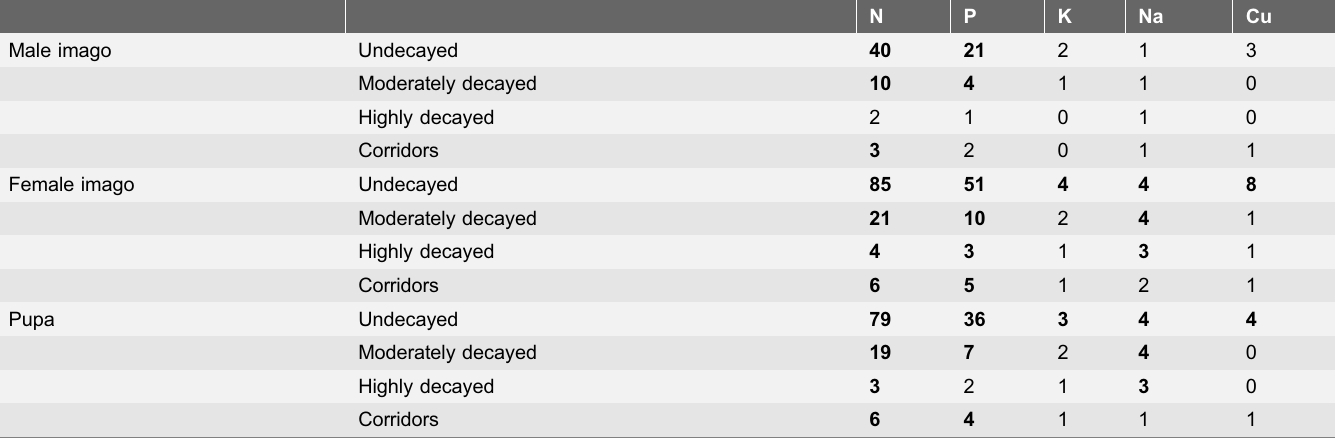
Table 4. Estimated minimum number of years a larva would need to spend feeding on wood of different decay categories to gather the amounts of the most limiting essential elements present in the bodies of adult beetles and pupae.